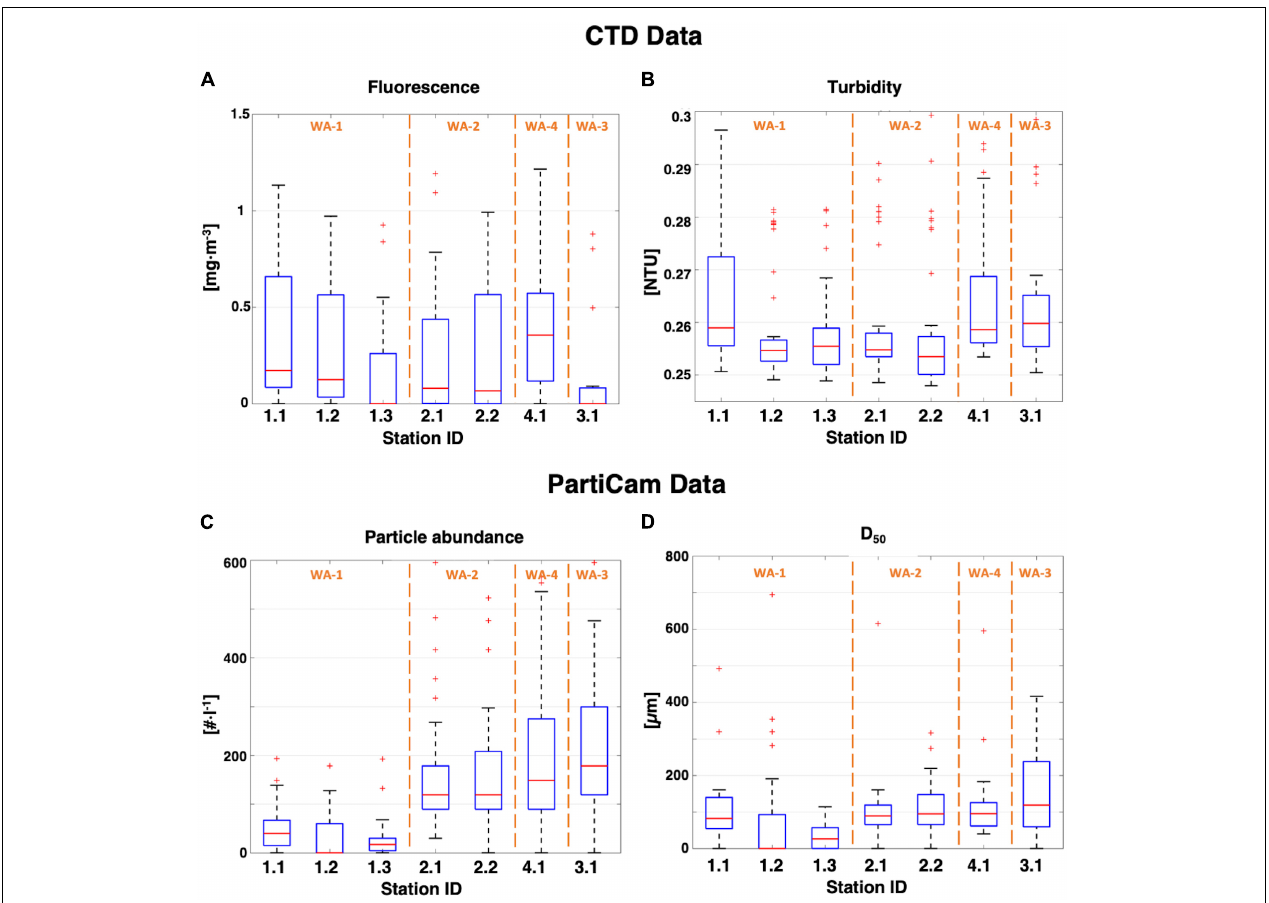
FIGURE 5 | Box plots of all CTD and PartiCam data from the shallow stations. (A) Chla and (B) turbidity data were measured with the CTD. (C) Particle abundance and (D) median diameter values were extracted from the PartiCam pictures. Upper and lower boxplot whisker represent the maximum and minimum values of the dataset. Interquartile range is shown as the blue box (50% of the dataset). Red line indicates the median value and red “+ ” are outliers. Working areas are shown in